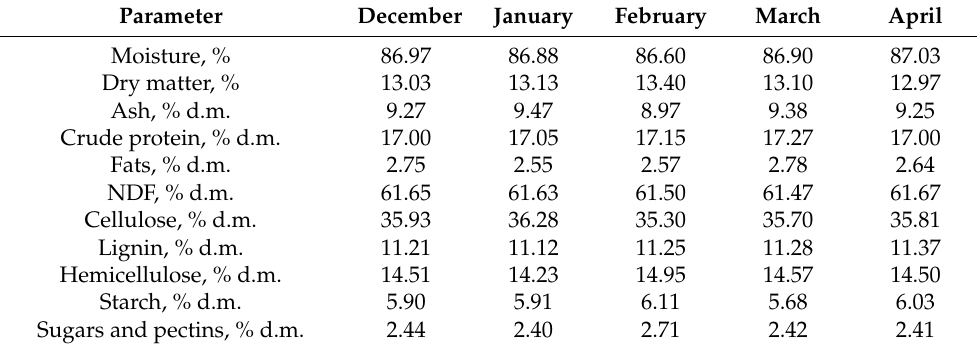
Table 6. Analysis of the composition of the Control feces, done with the portable NIR instru- ment Polispec.